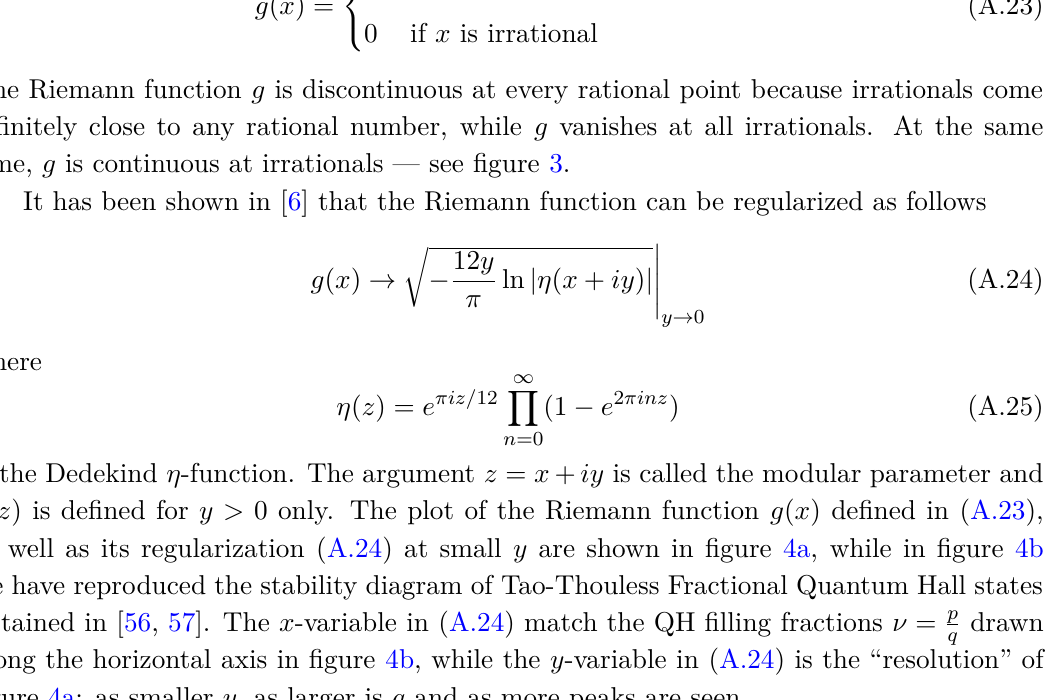
everywhere continuous but nowhere differentiable Weierstrass function). The